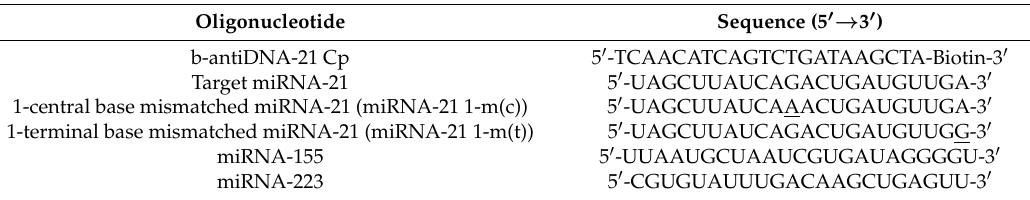
Table 6. Oligonucleotides used in this